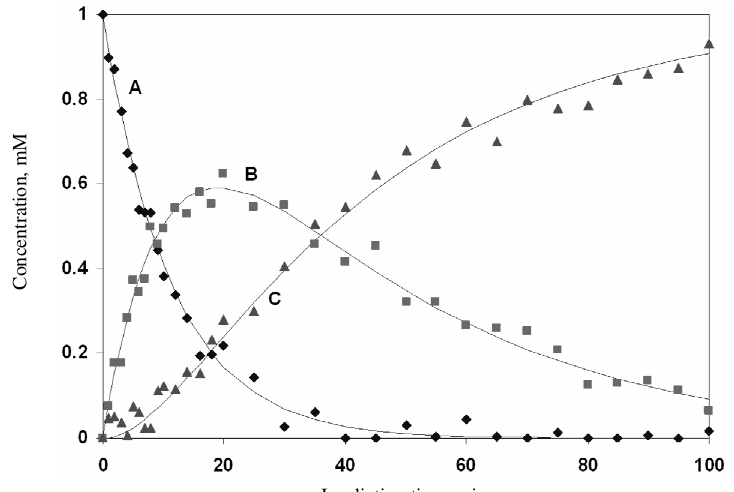
Figure 6. The concentration profiles of EE (A), EZ or ZE (B), ZZ (C) isomers of BDAE (MCR-ALS ( ■ , ▲ ) and fitted exponential function ( ―